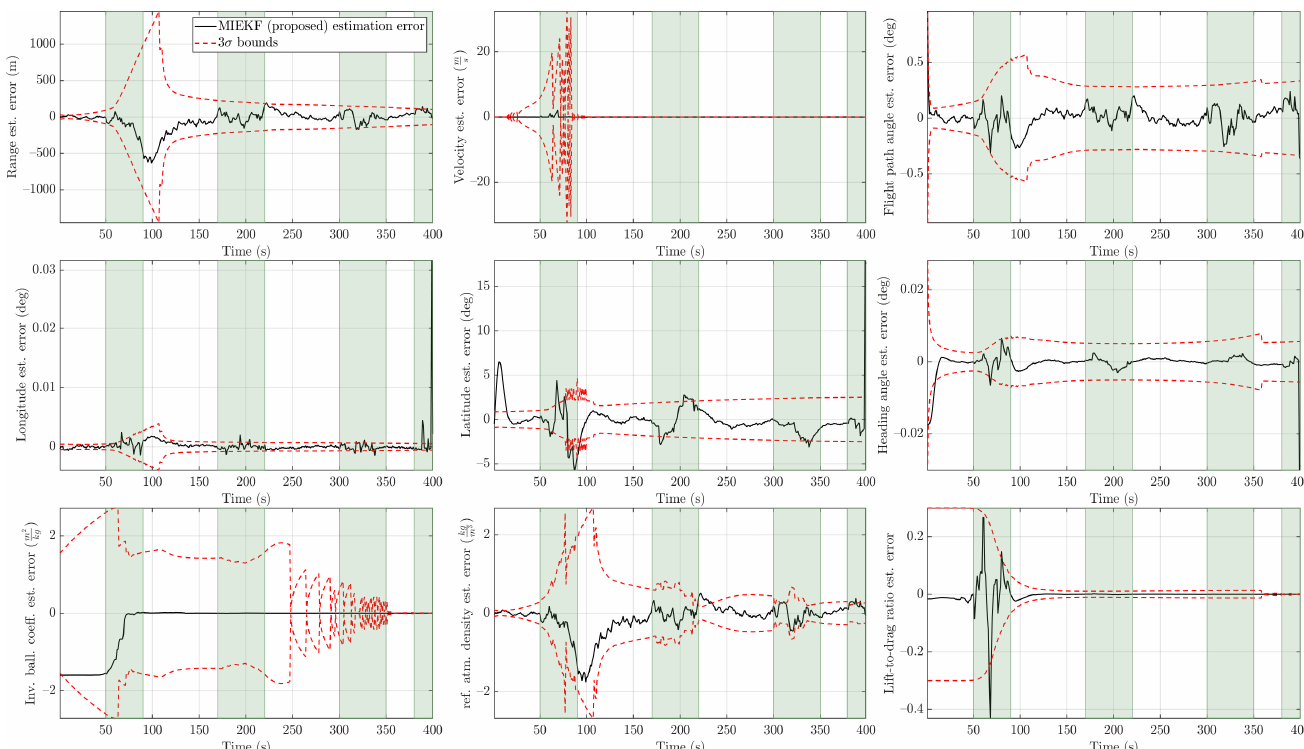
Figure 17. MIEKF estimation errors with 3 σ bounds for (cid:101) = 0.4 (the time intervals shaded in light green are intervals in which outliers are